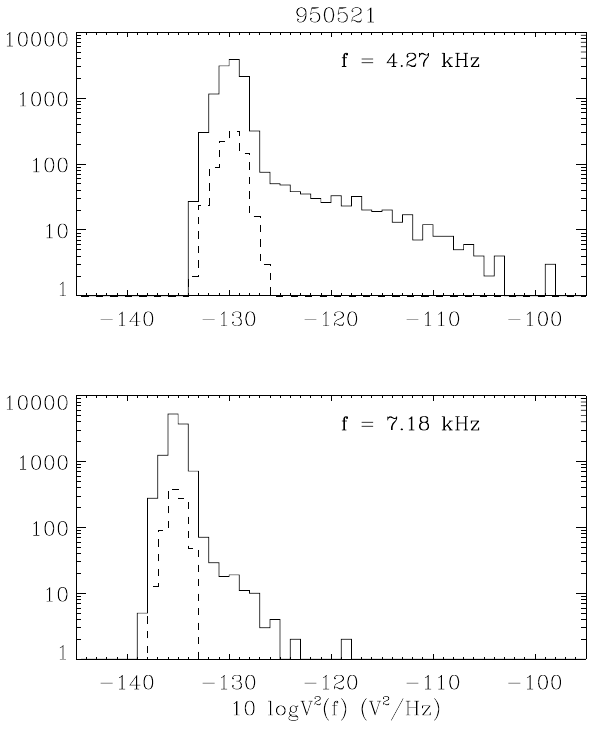
Fig. 4. Solid lines: histograms of the TNR spectral power at two frequencies, during 14h. Dashed lines: histograms at the same fre- quency during one hour with purely thermal